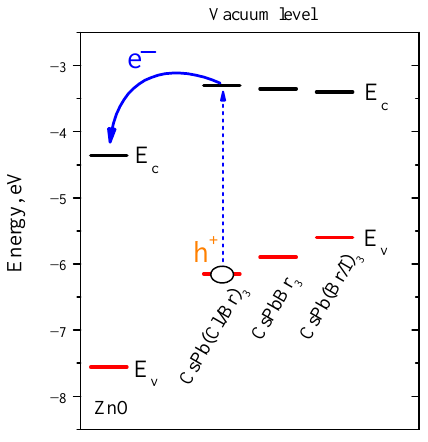
Figure 11. Comparative positions of the edges of the conduction bands (E c ) and the edges of the valence bands (E v ) of ZnO and PNCs relative to the vacuum level [66]. Blue arrows show the path of photoinduced electron ( e − ) transfer; the photogenerated hole ( h + ) remains in the valence band of